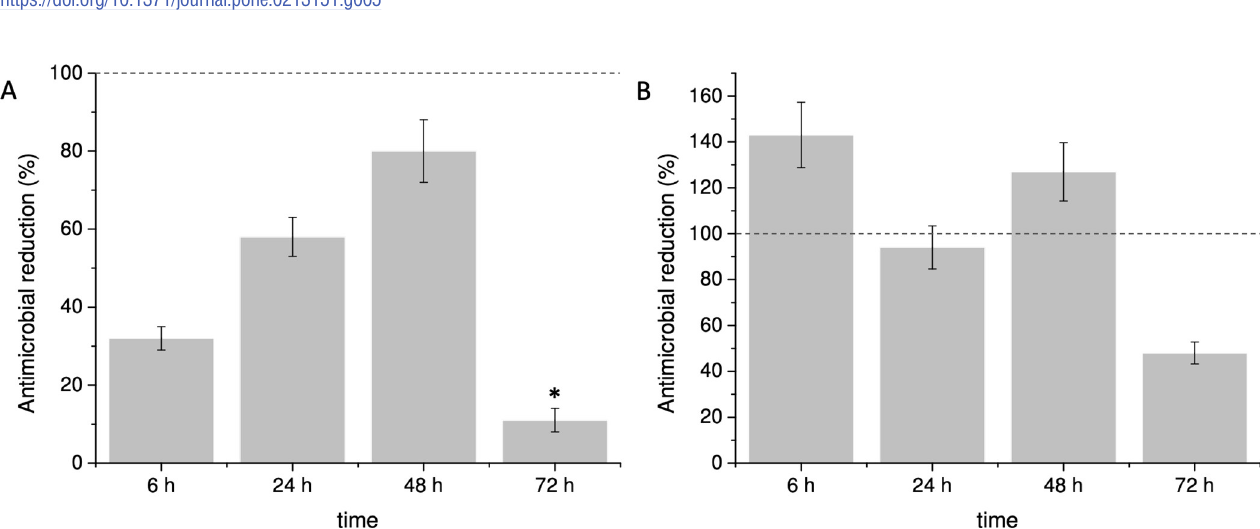
Fig 5. Antimicrobial activity of MoO 3 and Ag NP coatings against S . aureus strain ATCC25923. � and �� denote significant change (p < 0.05) compared to MoO 3 and Ag100, respectively.